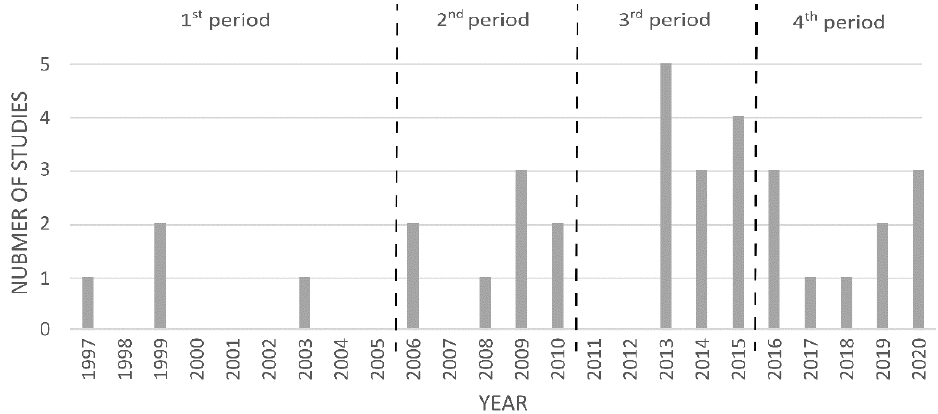
Figure 3. Frequency of the studies in relation to their publication year and the chosen time periods.